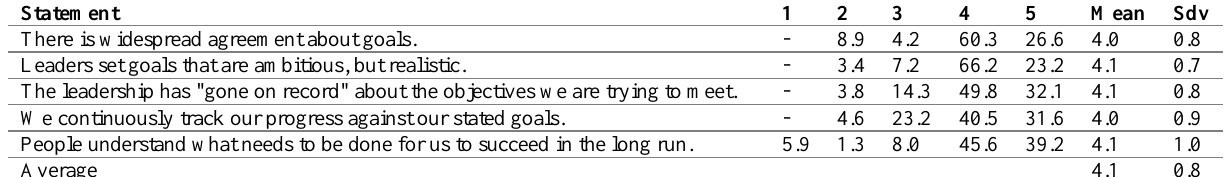
Table 4: Managers Perception on Clarity of Mission